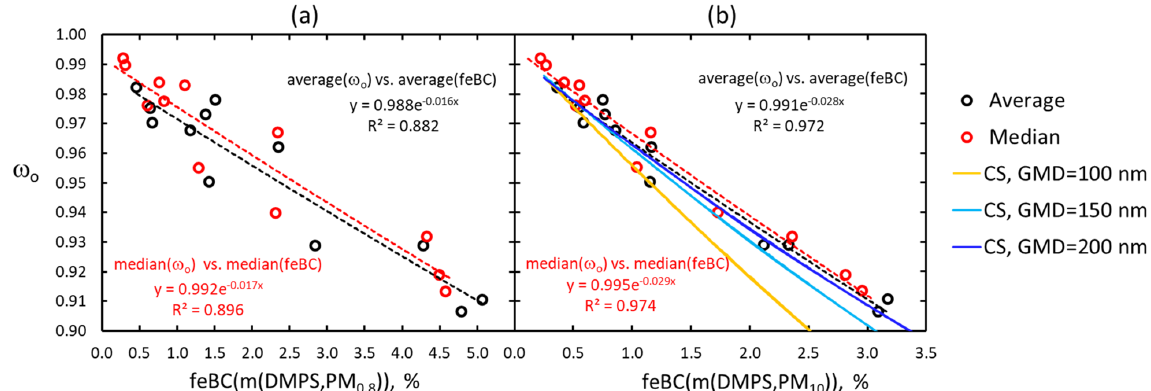
Figure 12. Monthly average and median ω o vs. eBC mass fraction calculated as the ratio of eBC to (a) m (DMPS,PM 0 . 8 ) and (b) m (DMPS,PM 10 ). The dashed lines represent fittings of ω o ( f eBC) = ω o (0)exp( − k · f eBC) with the data. The continuous lines in panel (b) represent simulations with a core-shell (CS) model for lognormal number size distributions with geometric standard deviation GSD = 1.8 and geometric mean diameter (GMD) shown in the